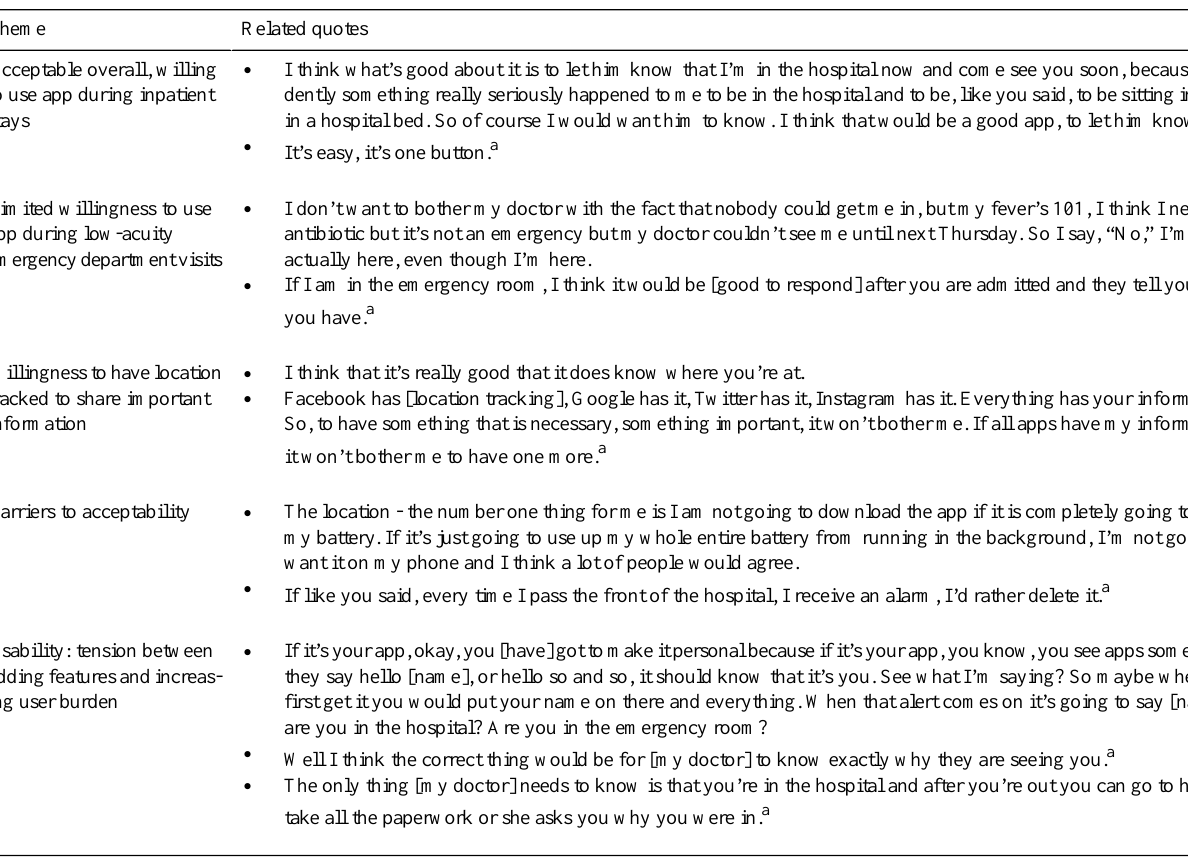
Table 2. Emergent themes from qualitative analysis of patient focus groups. Related